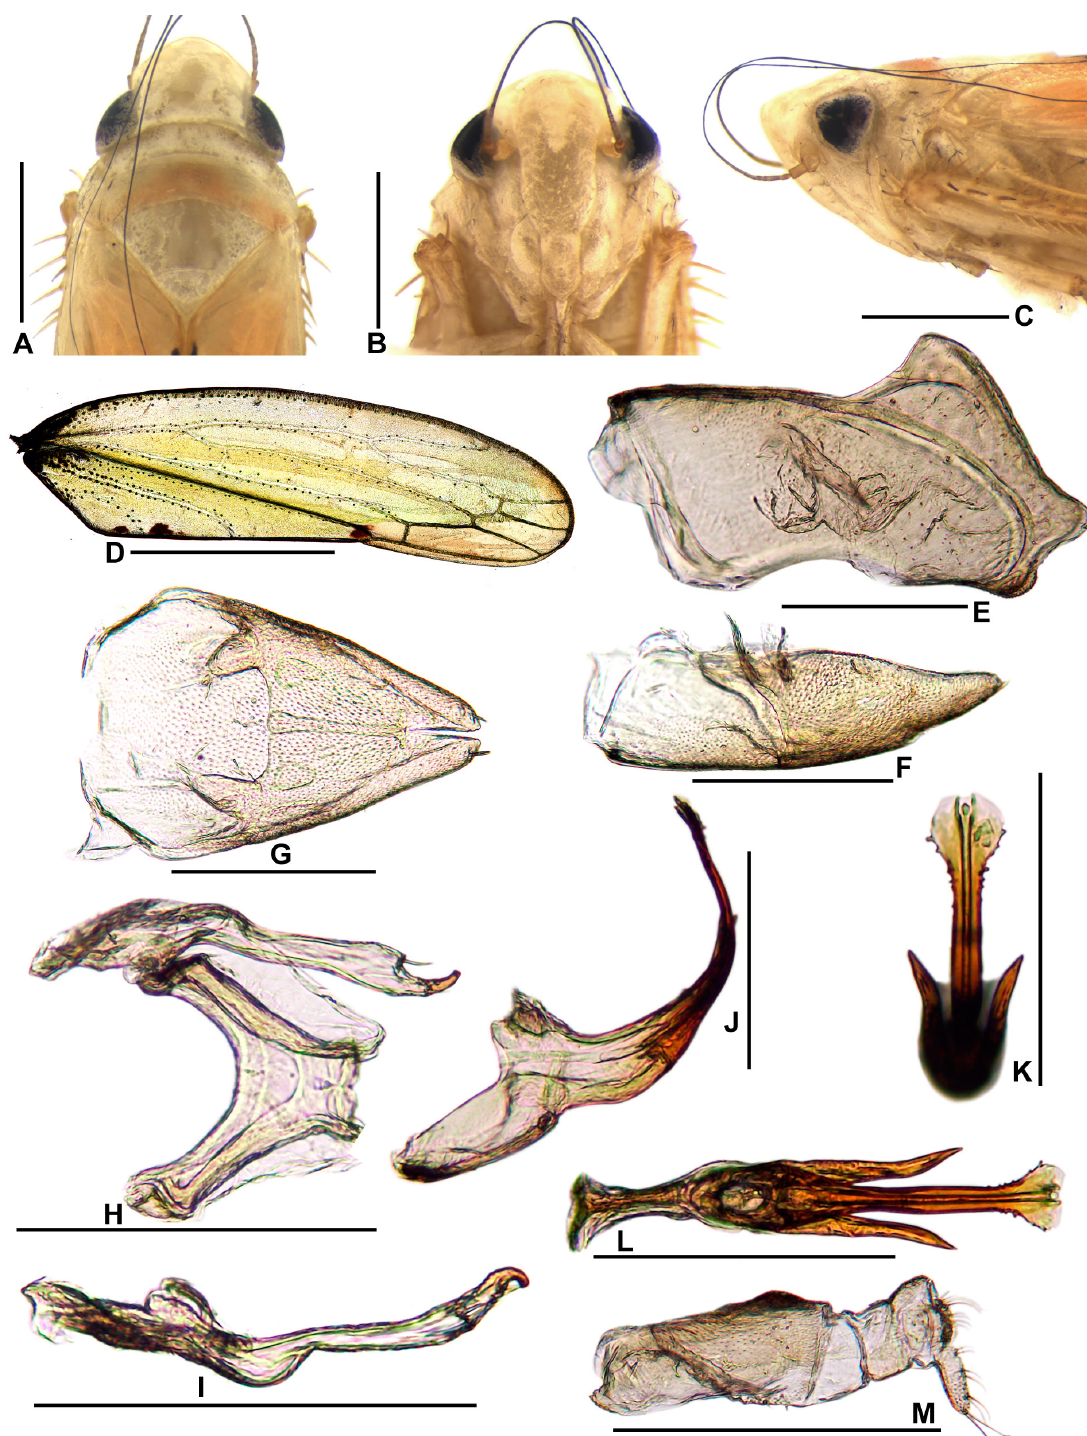
Fig. 3. Takiyaella cavichiolii gen. et sp. nov., ♂, holotype (DZUP 492451). A . Head and thorax, dorsal view. B . Head, frontal view. C . Head and thorax, lateral view. D . Forewing. E . Pygofer, lateral view. F . Valve and subgenital plate, lateral view. G . Valve and subgenital plate, ventral view. H . Style and connective, dorsal view. I . Style, lateral view. J . Aedeagus, lateral view. K . Aedeagus, caudal view. L . Aedeagus, ventral view. M . Anal tube, lateral view. Scale bars: A–C = 1.0 mm; D = 2.0 mm; E–I, M = 0.5 mm; J–L = 0.4